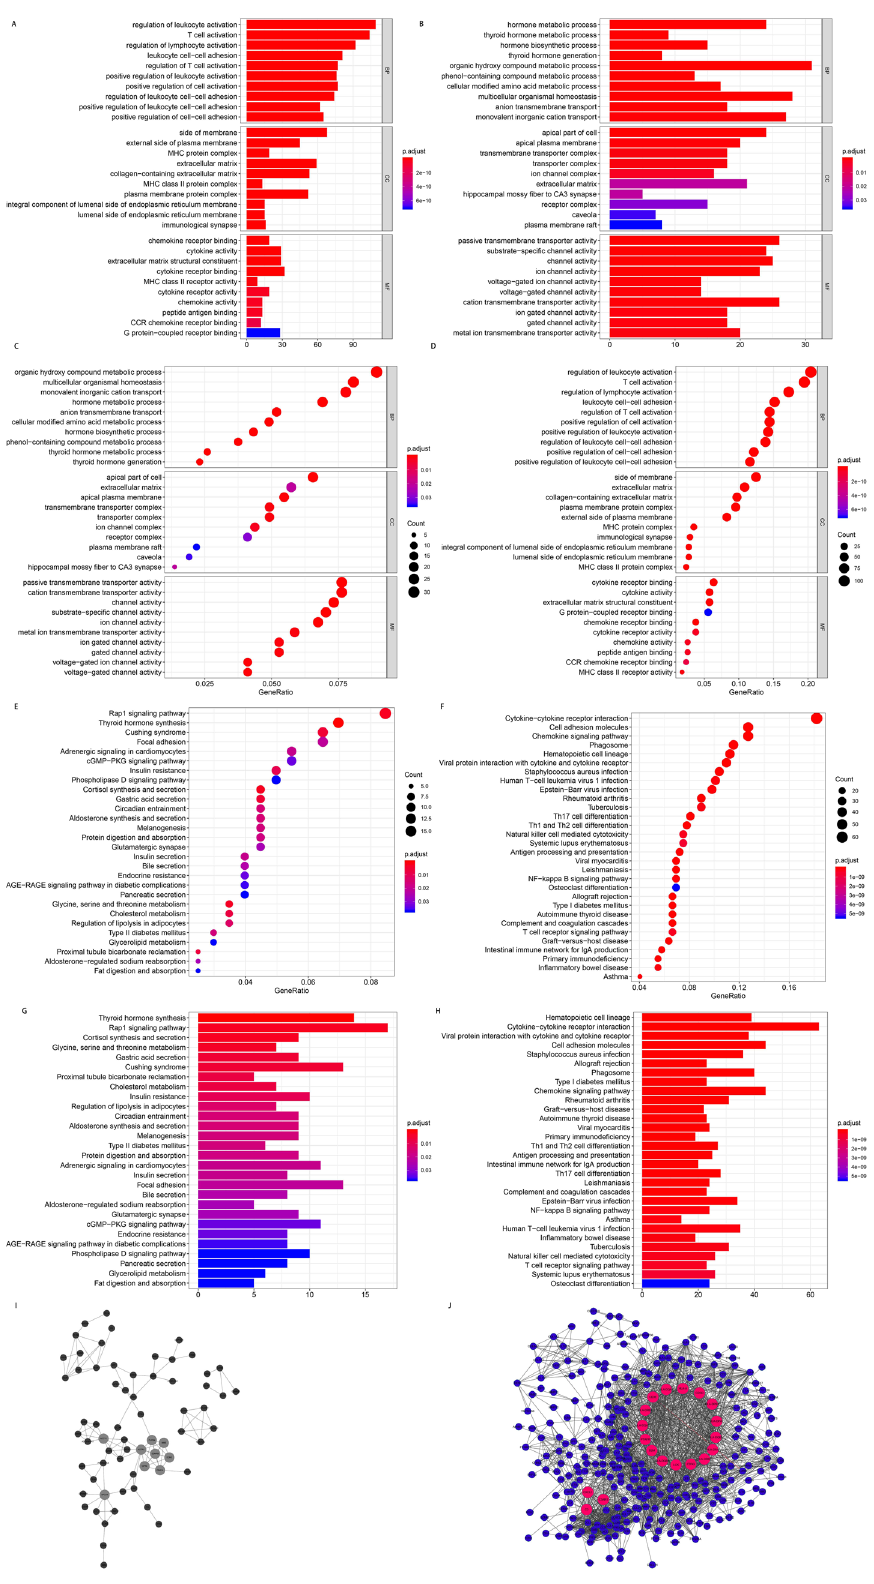
Figure 7. The GO, KEGG and PPI analysis of DEGs related to cold and hot tumors. ( A – D ) GO analysis of DEGs related to cold and hot tumors. ( E – H ) KEGG pathway analysis of DEGs related to cold and hot tumors. ( I , J ) PPI analysis of DEGs related to cold and hot tumors. ( I ) The down-regulated genes. ( J ) The up-regulated genes. BP, Biological Process; CC, Cellular Component; MF, Molecular Function; GO, Gene Ontology; KEGG, Kyoto Encyclopedia of Genes and Genomes; PPI, Protein– protein Interaction; DEGs, Differentially Expressed